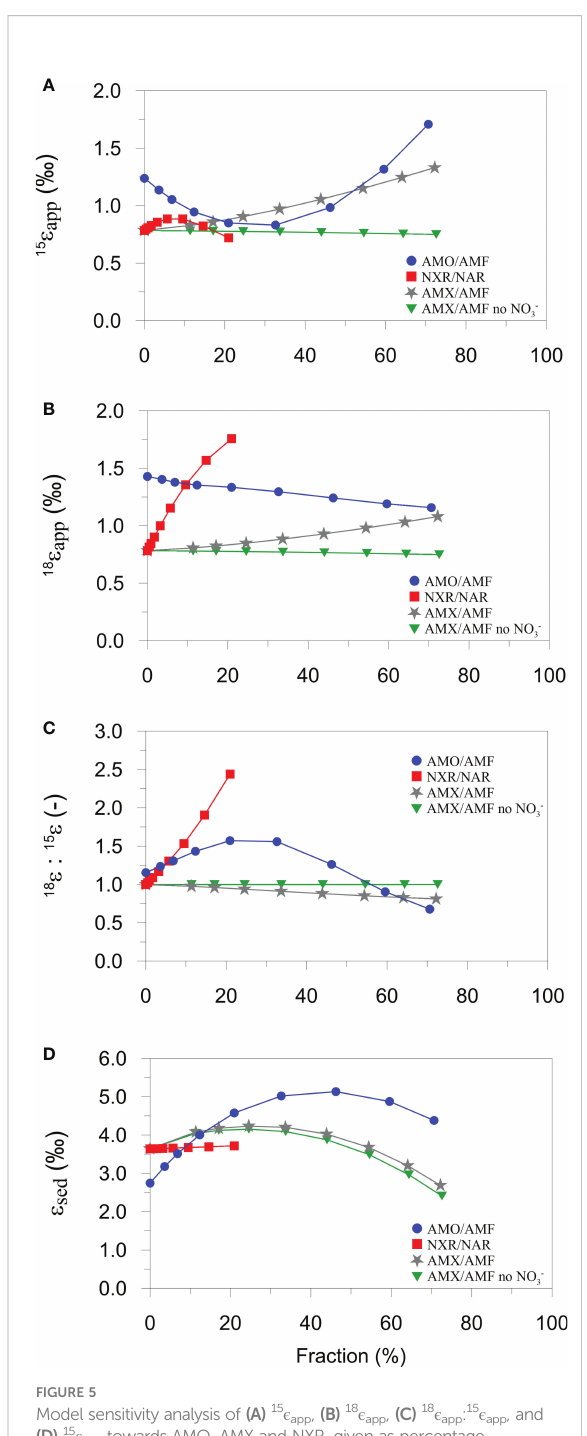
FIGURE 5 Model sensitivity analysis of (A) 15 ϵ app , (B) 18 ϵ app , (C) 18 ϵ app : 15 ϵ app , and (D) 15 ϵ sed towards AMO, AMX and NXR, given as percentage contributions to AMF or NAR. Blue, red and grey curves were generated by varying the rate constant for AMO (k AMO ), NXR (k NXR ), and AMX (k AMX ) stepwise between 0 and 2.6 × 10 7 cm 3 µmol -1 yr -1 . The green curves are the results for AMX/AMF without oxidation of NO 2- to NO 3- . All other parameter values in Table 3 and Table S2 are held